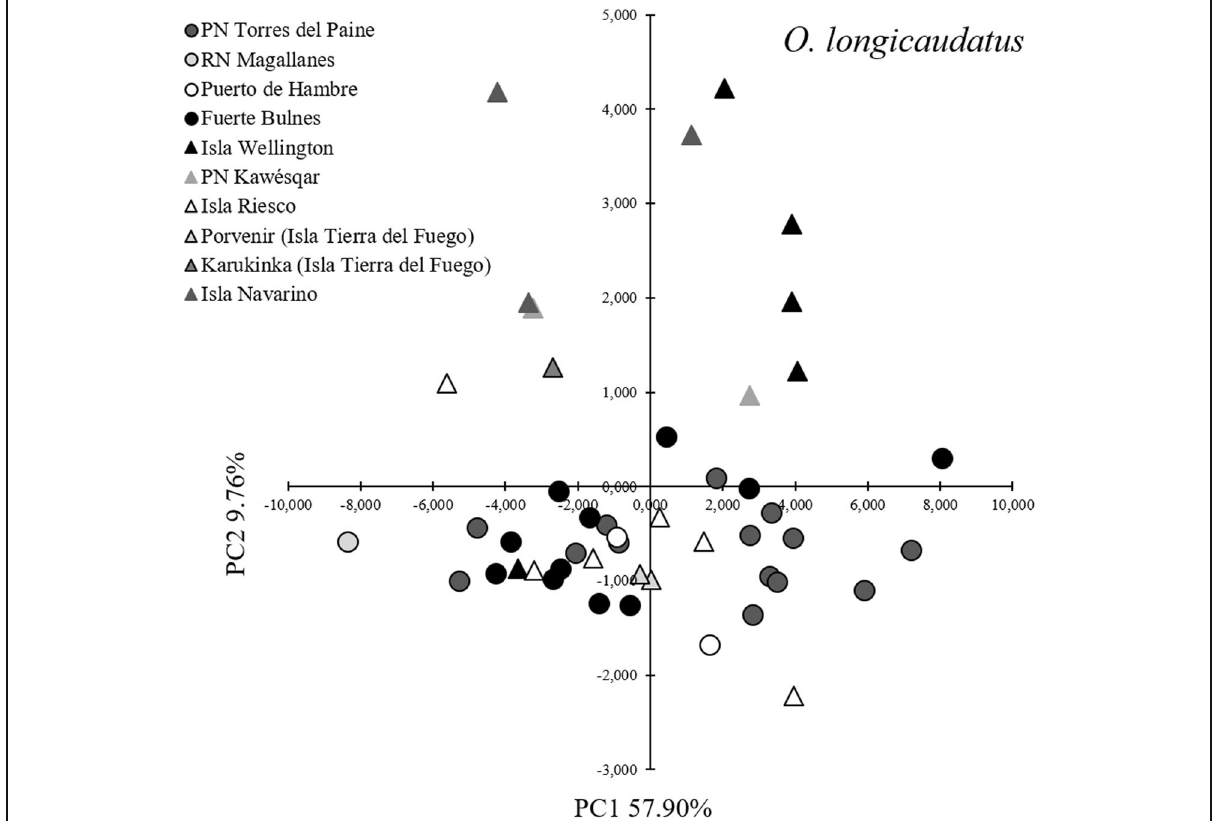
Fig. 4 Principal Component Analysis (PCA) of linear morphometric approach for O. longicaudatus along Principal Component 1 and 2 (PC). PN = Parque Nacional. RN = Reserva Nacional, circles = mainland localities, triangles= insular